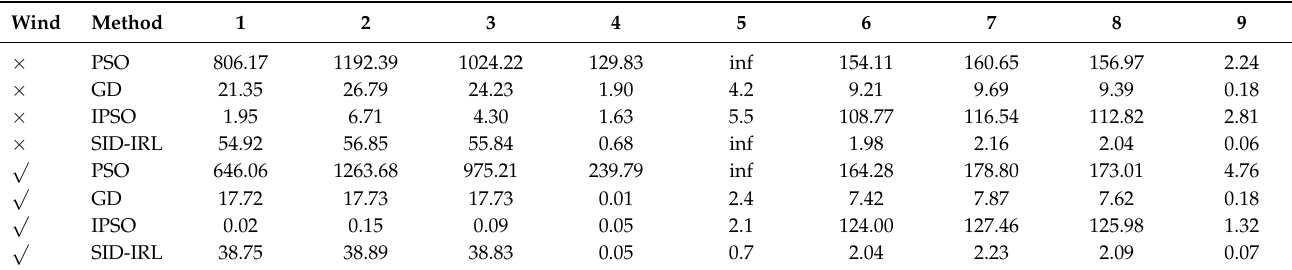
Table 5. Comparison results of case